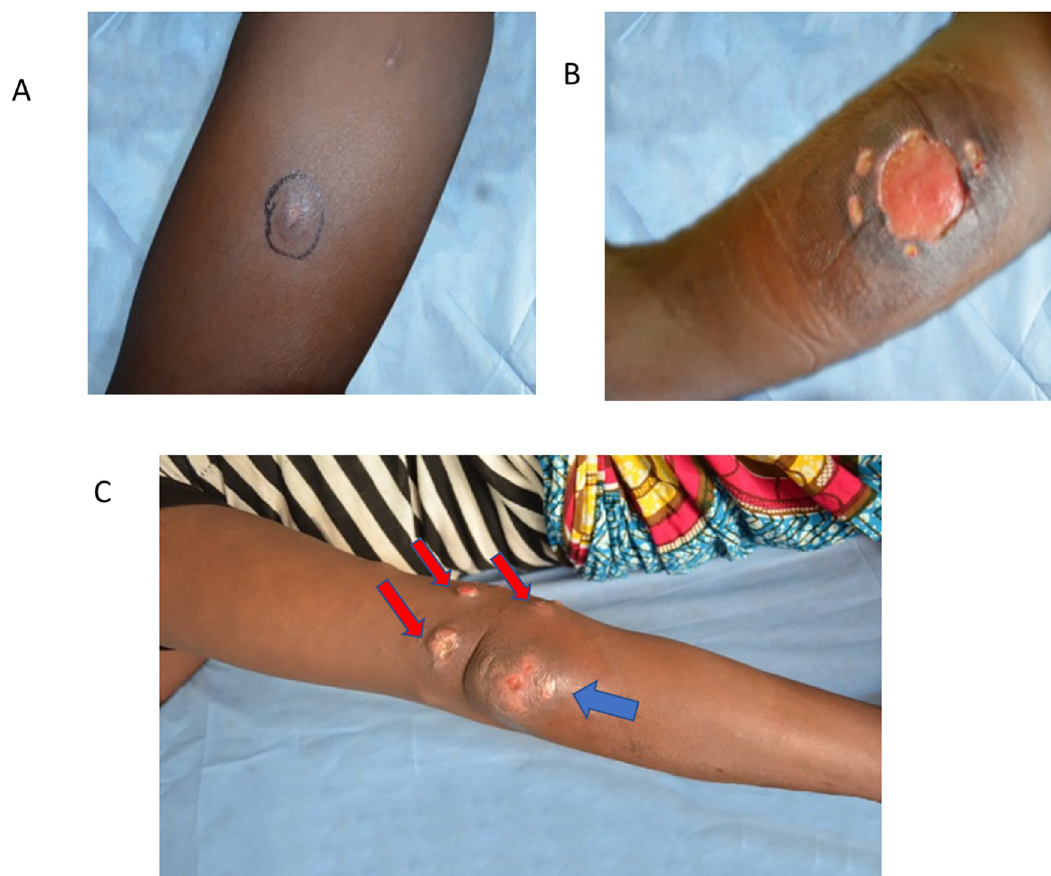
Fig 2. Typical paradoxical reactions in Buruli ulcer following antibiotic treatment. A: New nodular lesion on the left thigh of a patient with an indurated lesion before antibiotic treatment, B: Paradoxically enlarged ulcer of lesion A during antibiotic therapy at week 4. C: Multiple new lesions (red arrows) around the original lesion on the left elbow (blue arrow) at week 5 of antibiotic treatment.